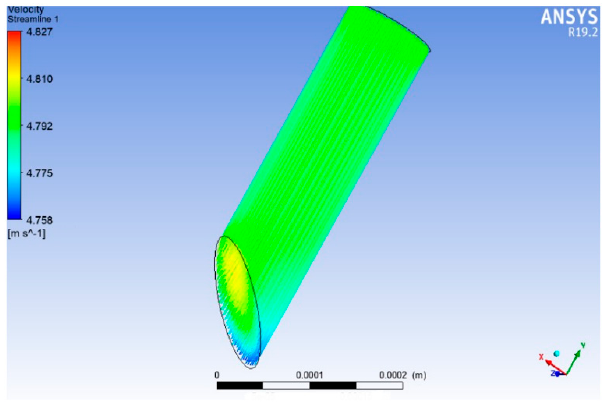
Figure 8. Velocity vectors for the microneedle outlet.